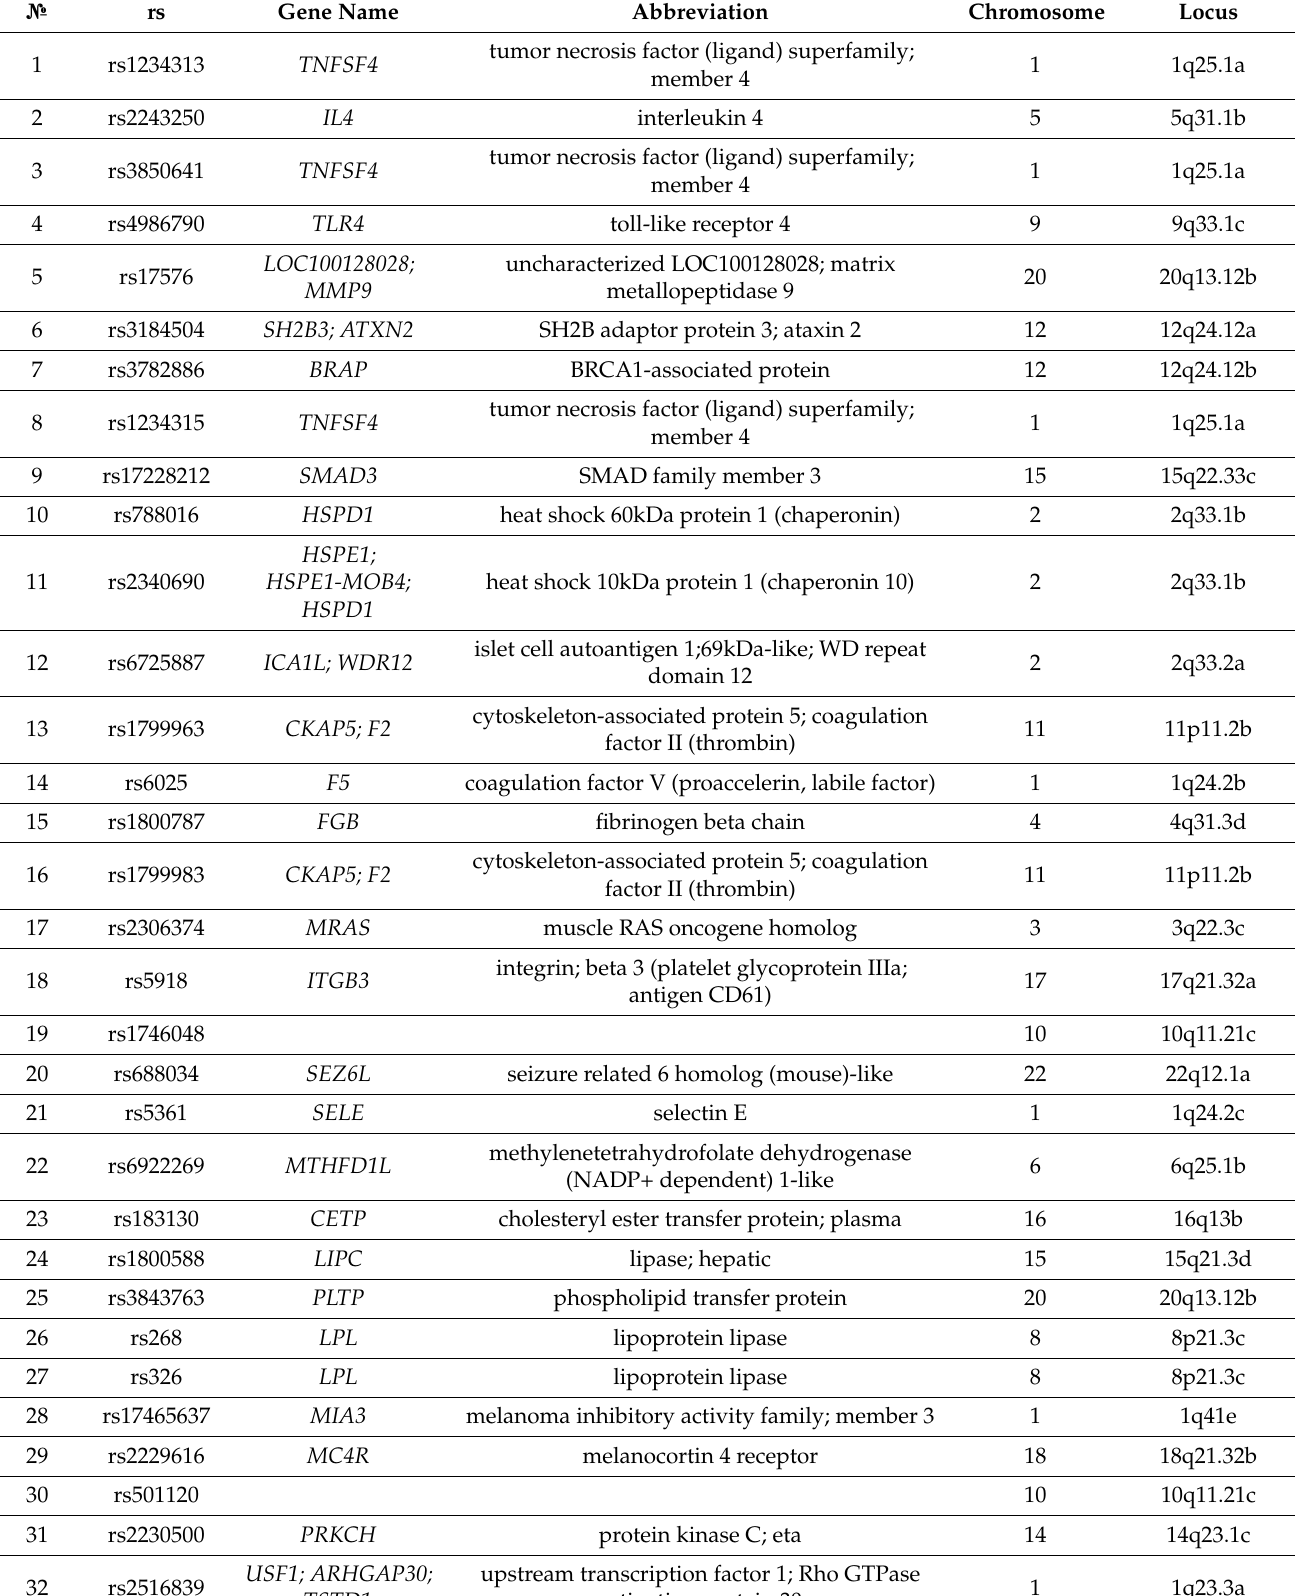
Table 2. Panel of polymorphisms associated with cardiovascular events after coronary artery